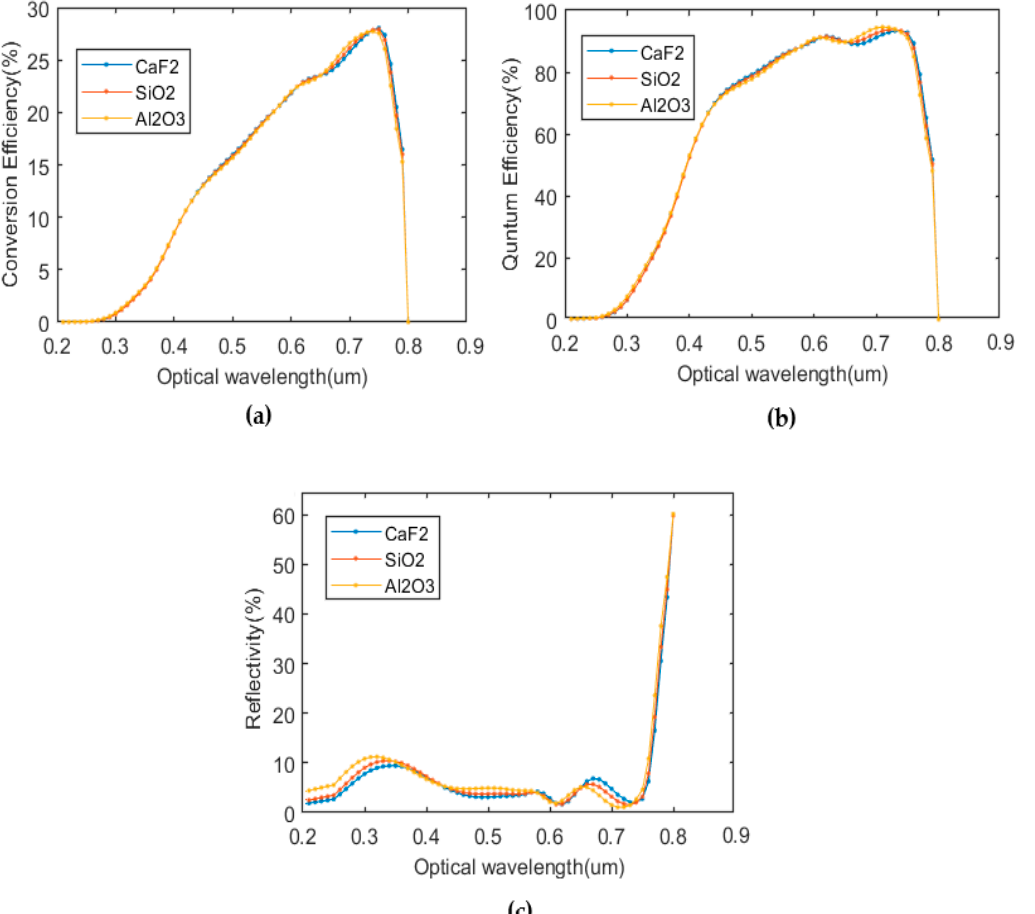
Figure 10. ( a ) Effects of using various anti-reflective coatings on the efficiency of the inverted planar PSC, ( b ) effects of using various anti-reflective coatings on the quantum efficiency of the inverted planar PSC, and ( c ) light reflection by various anti-reflective coatings on the inverted planar PSC.